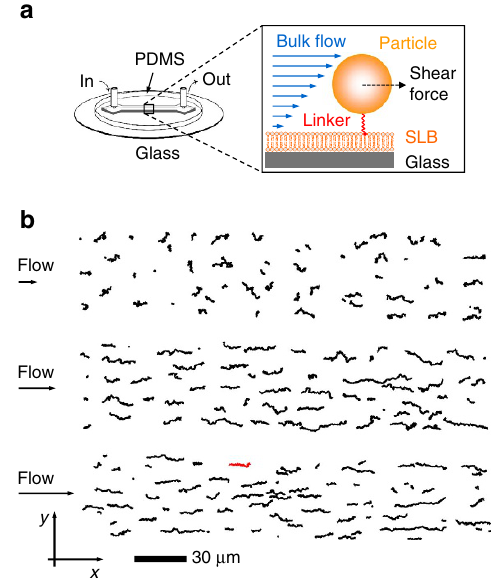
Figure 1 | Size determination of nm-sized objects using 2D flow nanometry. ( a ) The objects (for example, gold nanoparticles or liposomes) are linked to a fluid interface (for example, a fluid-phase SLB) within a microfluidic channel (using a design as recently described 27 ). The linking confines the object’s movement into two dimensions, but maintains its ability to move freely. Its movement is monitored from below, for example using scattering, confocal or TIRF imaging. This is demonstrated in b for the particular example of streptavidin-functionalized gold nanoparticles (hydrodynamic radius 30nm) that are linked to biotinylated lipids in the SLB and label-free monitored using surface-enhanced ellipsometric contrast (SEEC) imaging. Application of a flow through the channel creates a shear force, which depends on the flow rate (applied to the channel; 5 m lmin (cid:3) 1 , 10 m lmin (cid:3) 1 and 15 m lmin (cid:3) 1 from top to bottom in b ) and the object’s hydrodynamic size. Shown are only the first 100 frames ( ¼ steps) of each trajectory corresponding to an observation time of 3s. The red trajectory is further analysed in Fig.